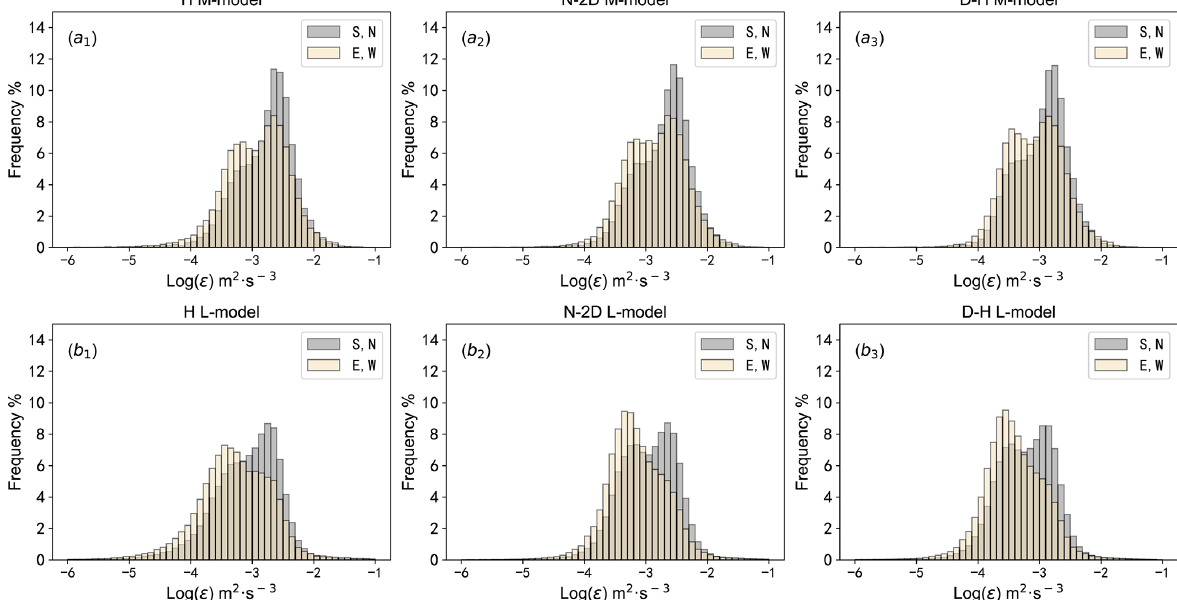
Figure 7. Distribution of ε in the middle and low modes of the Beijing MST radar in the range of 3–7.8km from 2012–2014: (a.1–a.3) dis- tributional characteristics of ε in the H model, N-2D model and D–H model (mid-mode); (b.1–b.3) as in (a.1–a.3) but for low-mode data. The grey bars are the result of north and south beams, and the yellow bars are based on the east and west beams.